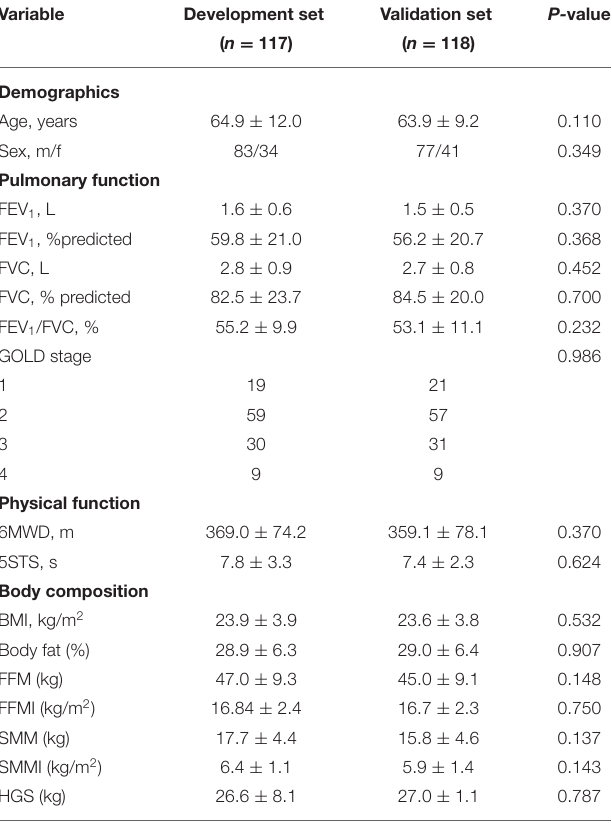
TABLE 1 | Baseline characteristics of